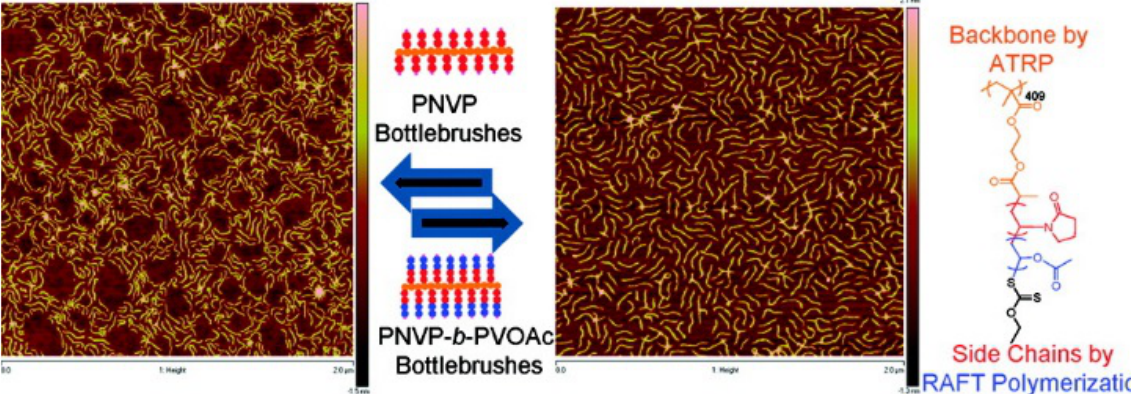
Figure 3. Molecular brushes by RAFT polymerization from an